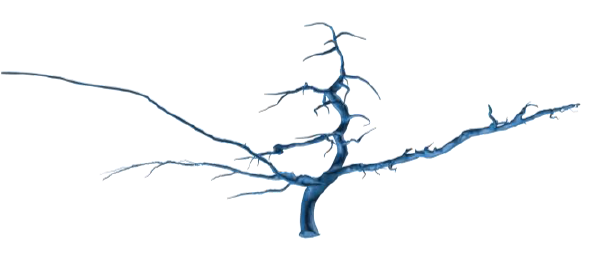
Figure 9. Polygon model of black pine trunk